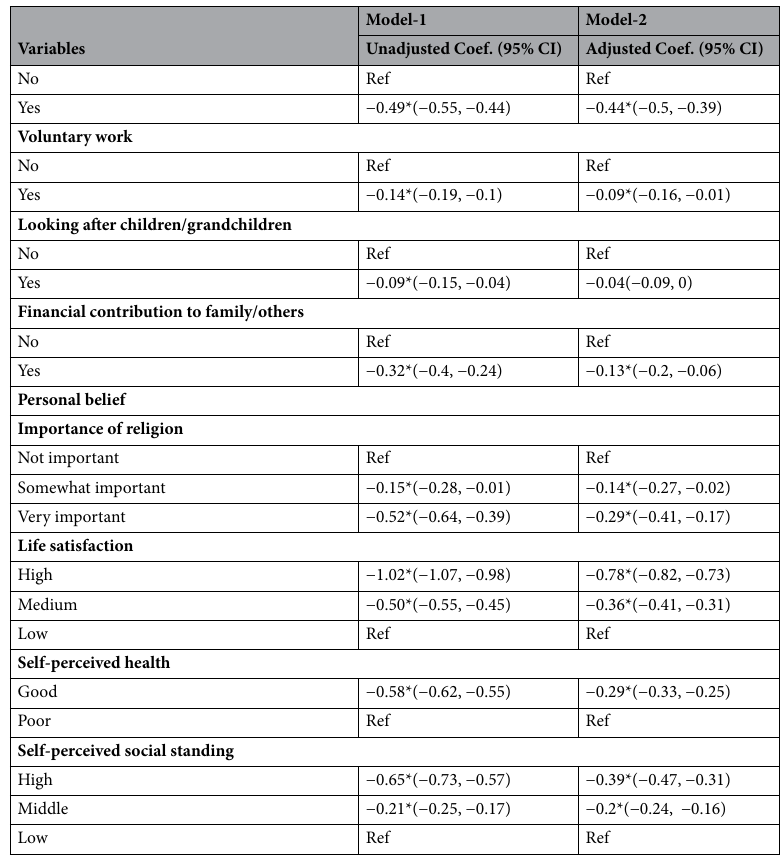
Table 3. Regression estimates for depression among older adults in India, 2017–18. Ref: Reference; CI: Confidence interval; *if p < 0.05; Model-1 represents the unadjusted estimates; Model-2 represent the adjusted estimates (adjusted for personal effort, personal beliefs and socioeconomic and demographic